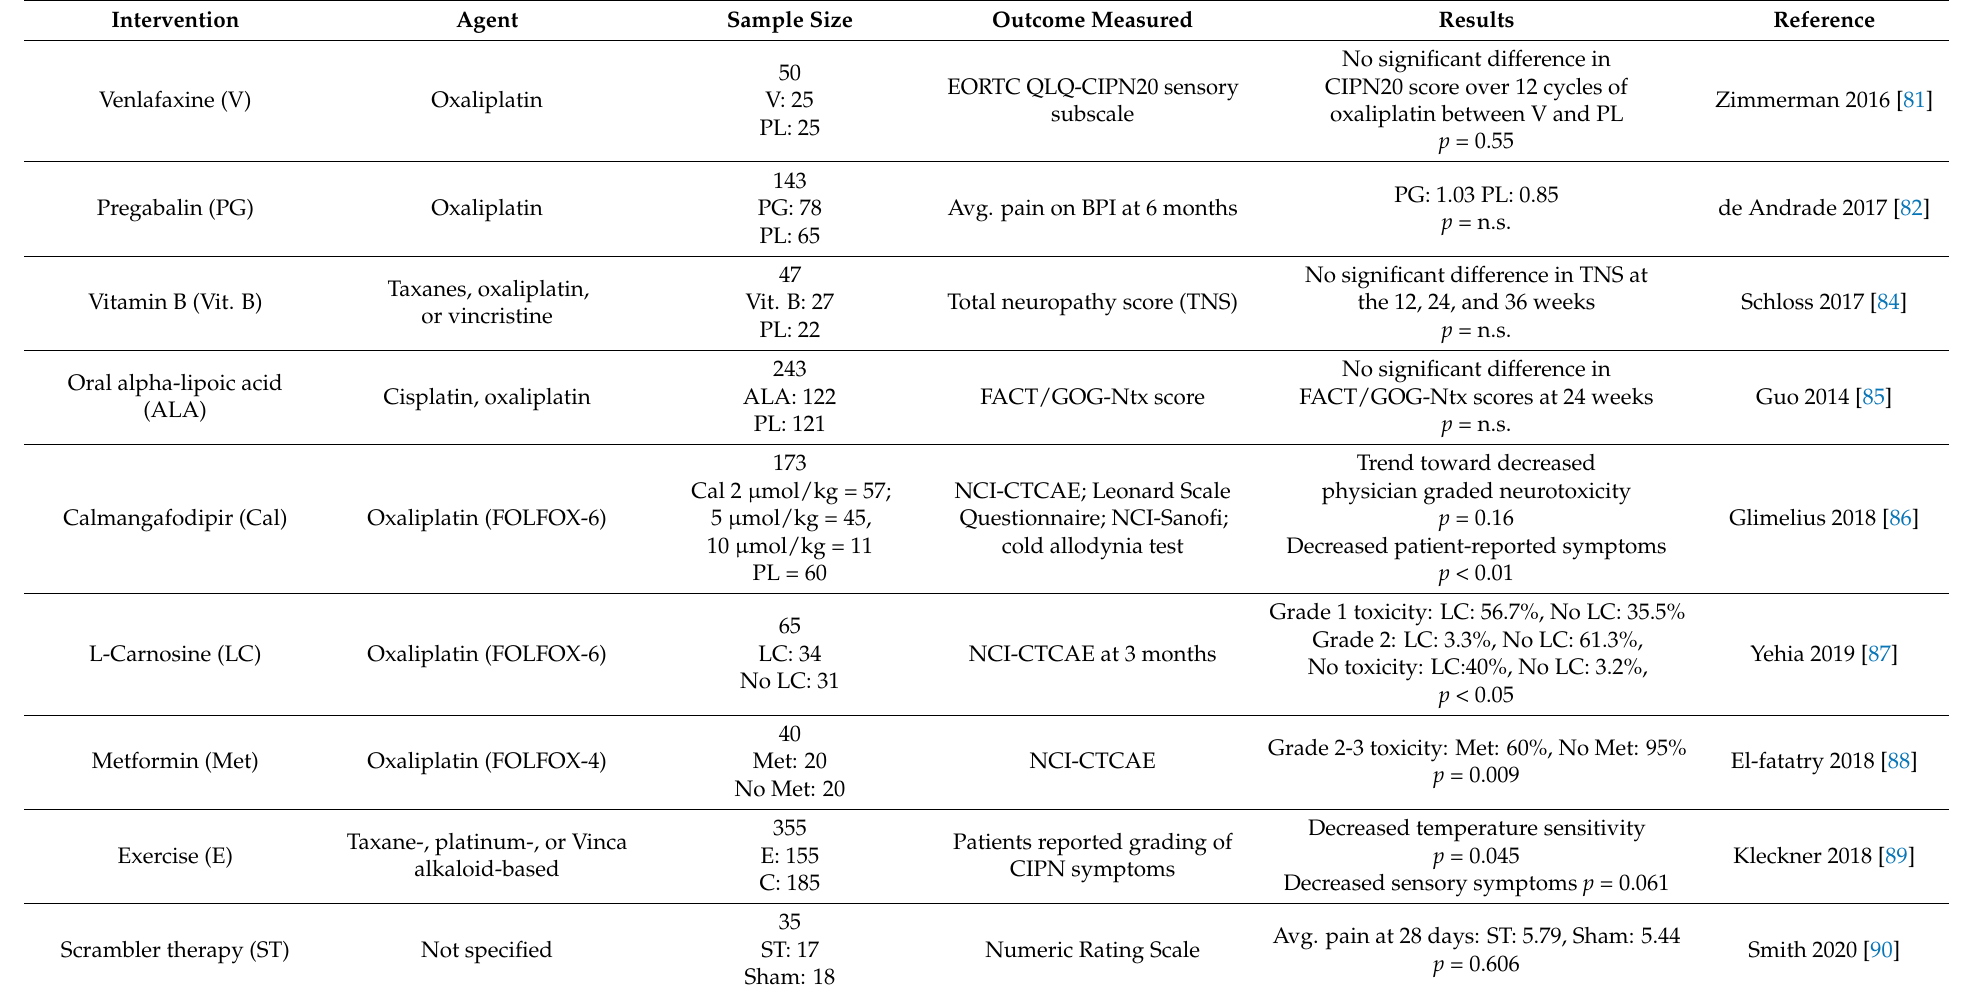
Table 1. Prevention and treatment of CIPN in prospective randomized clinical